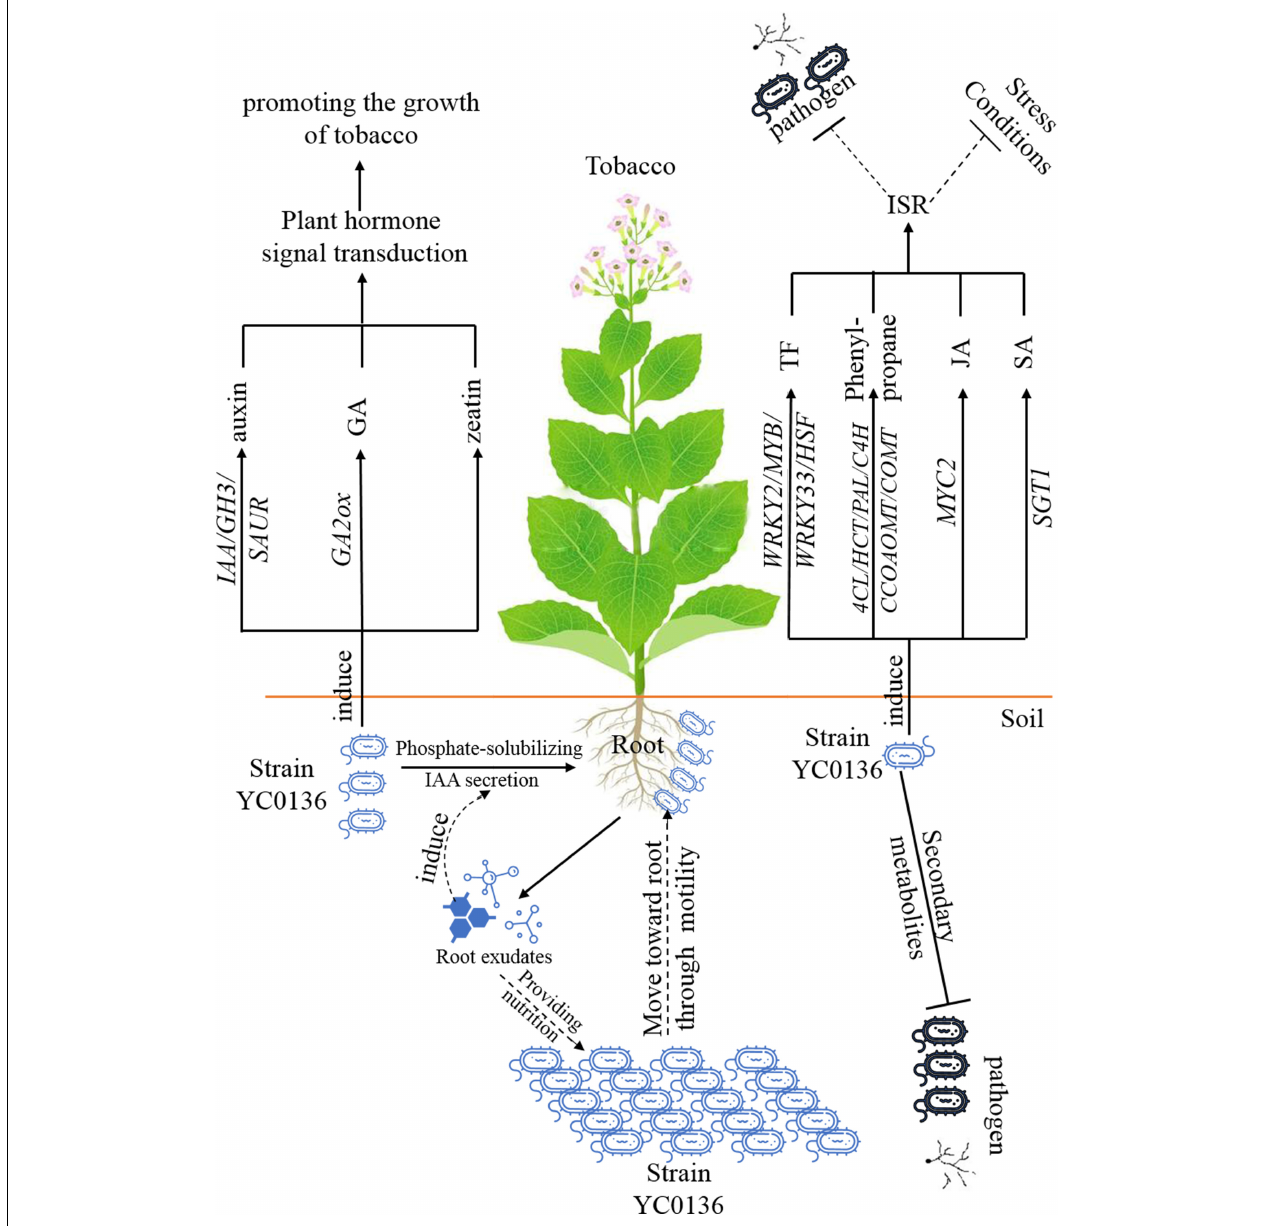
FIGURE 7 | Proposed model of the growth-promoting mechanisms of strain YC0136 on tobacco.